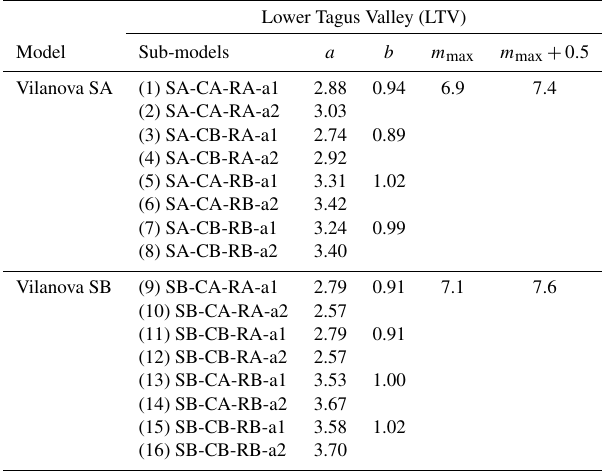
Table 2. Earthquake recurrence parameters ( a , b , m max ) for the Lower Tagus Valley (LTV) source zone for the 16 combinations (column “Sub-models”) in the logic tree proposed by Vilanova and Fonseca (2007). Each combination has, in addition, two possible maximum magnitudes, resulting in 32 possible recurrence models. Note that a and b are constants and m max represents the maximum